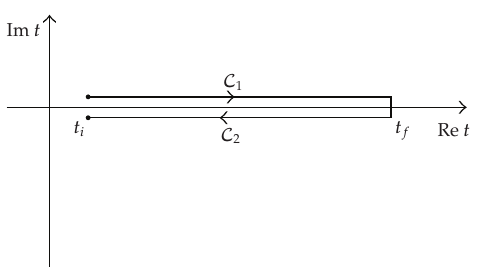
Figure 1: Integration path in the complex-time plane used in the CTP method. The forward and backward lines are infinitesimally close to the real